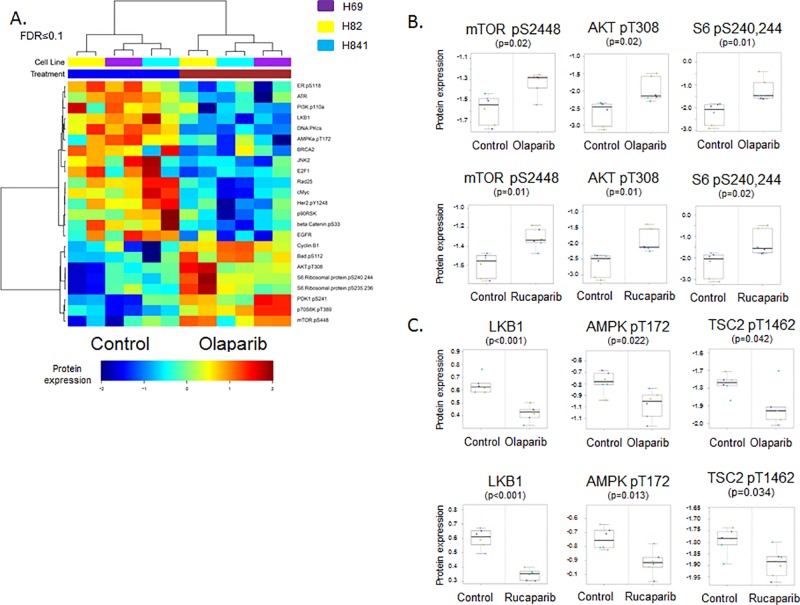
PARP inhibition increases PI3K/mTOR pathway activity through LKB1 inactivation in vitro.(A) Hierarchical clustering of proteins identified in lysates from SCLC cell lines (H69, H82, H841) treated with vehicle or olaparib for 24 hours revealed increased activity of the PI3K/mTOR pathway following PARP inhibition (FDR≤0.1, equivalent p-value≤0.037). (B) Individual phosphorylated proteins in the PI3K/mTOR pathway (p-mTor, p-AKT and p-S6 kinase) are increased following treatment with either olaparib or rucaparib (p≤0.02). (C) Lysates from cell lines treated with olaparib or rucaparib versus vehicle for 24 hours show inactivation of the LKB1 pathway (LKB1, pAMPKα, and pTSC2; p≤0.042).